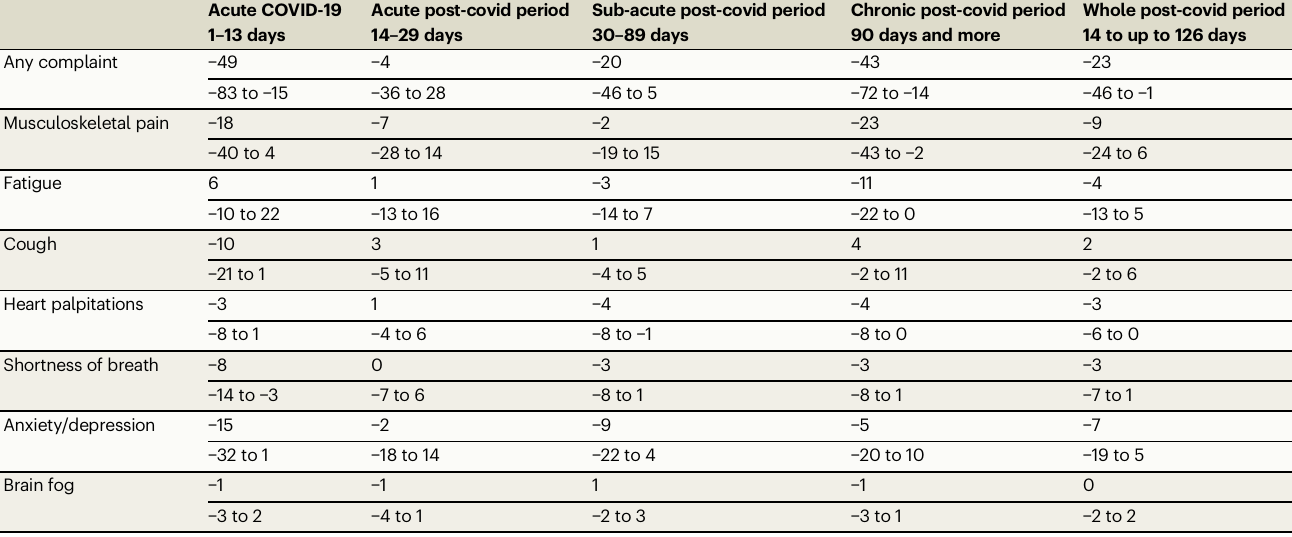
Table 2 | The differences between the group being infected with Omicron and the group being infected with Delta in pre- valence of different post-covid complaints over